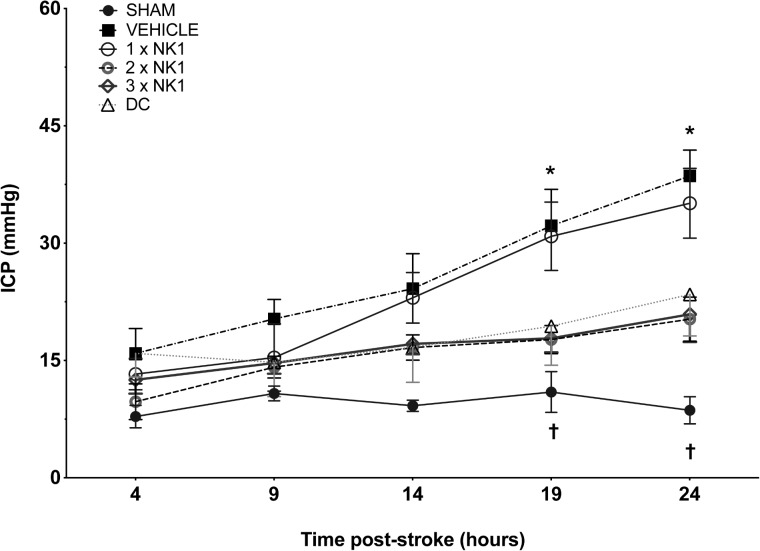
24 h ICP following MCAO. There was no significant difference in sham ICP across any of the time points. At 14 h post-stoke ICP was elevated in vehicle animals compared to sham (p < 0.05) and by 19 h post-stroke, ICP was significantly elevated in vehicle (p < 0.001) and 1×NK1 (p < 0.01) treated animals when compared to 2×NK1 (p < 0.05), 3×NK1 (p < 0.05) and DC treatment groups (p < 0.05). By 24 h, ICP remained significantly elevated in vehicle animals compared to sham (p < 0.0001), 2×NK1 (p < 0.01), 3×NK1 (p < 0.01) and DC (p < 0.05) treatment groups. ICP also remained elevated at 24 h post-stroke in 1×NK1 treatment groups compared to sham (p < 0.001) and 2×NK1 (p < 0.05). Data presented as mean ± SD. ∗p < 0.05 compared to sham; †p < 0.05 compared to vehicle.